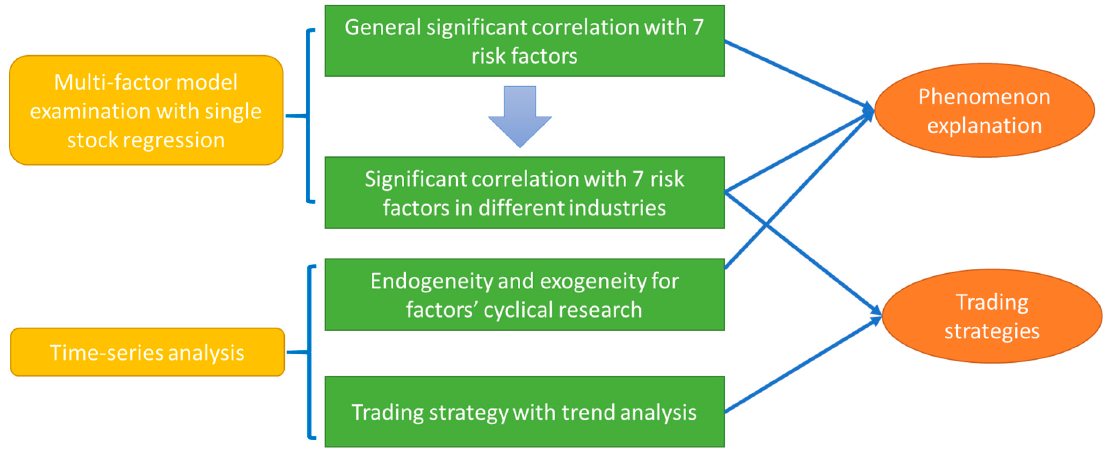
Figure 1. Multi-factor model examination with single stock regression and time-series analysis.